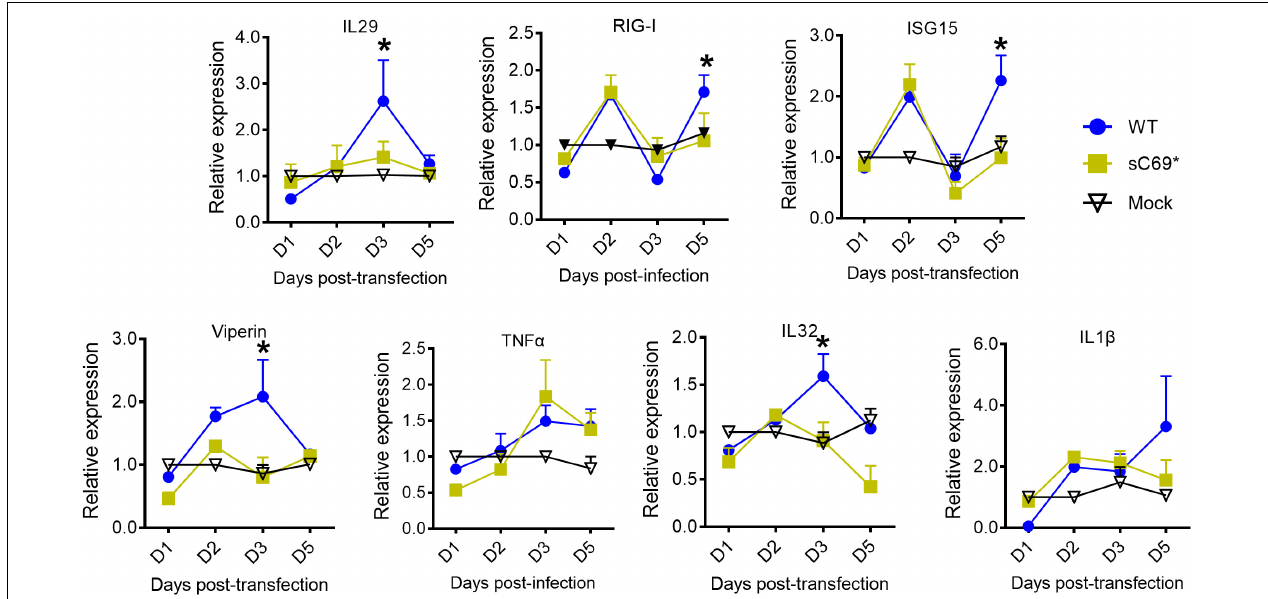
FIGURE 6 | The truncated protein of sC69 ∗ attenuates the host innate immune response. RT-qPCR was used to detect the mRNA levels of IL29, ISG15, RIG-I, viperin, IL1 β , and IL32. Data from three biological replicates are shown as means ± s.d. Statistical analysis was performed by a Student’s t -test ∗ p <